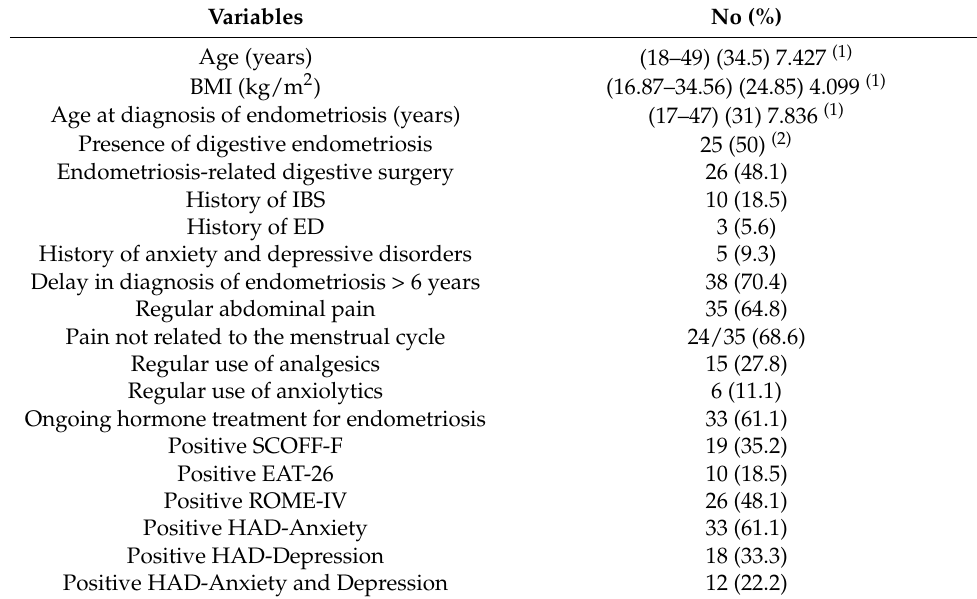
Table 2. Characteristics of the 54 responding patients included in the final analysis. BMI: Body Mass Index; IBS: Irritable Bowel Syndrome; ED: Eating Disorders; SCOFF-F: Sick, Control, One, Fat, Food-French version score; EAT-26: Eating Attitudes Test-26; HAD: Hospital Anxiety and Depression Scale.